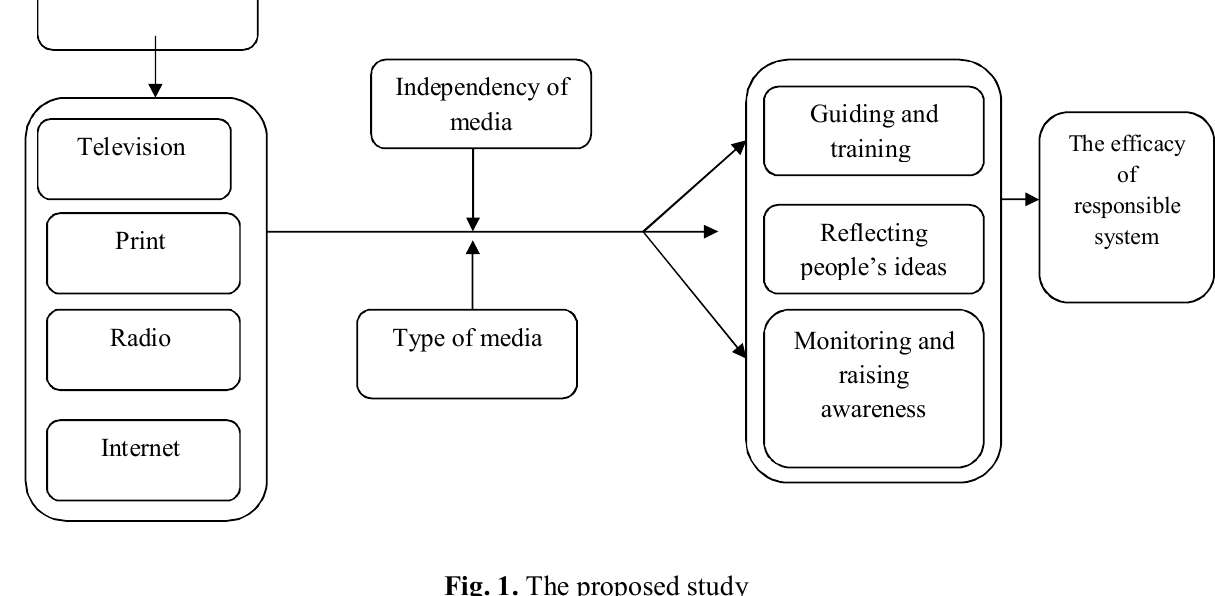
Fig. 1. The proposed